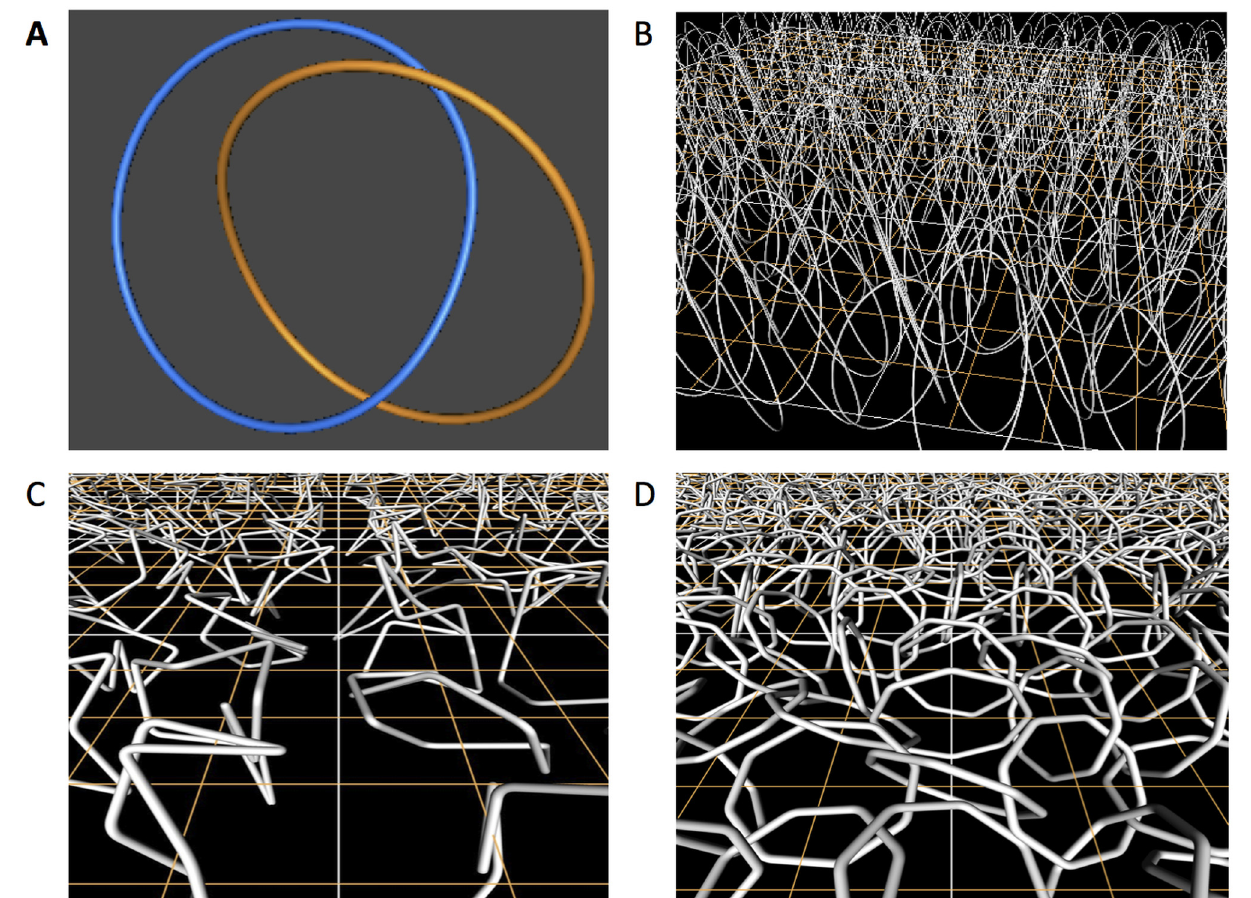
Fig 1. Hopf Links and Models proposed to analyze the topological properties of the minicircle network. A: A Hopf link; B: A grid of minicircles whose orientation has been biased. Volume effects are not considered and minicircle thickness is shown to help trace the trajectory of each minicircle; C: A grid of minicircles represented by freely jointed closed chains to study the effects of DNA bending; D: A grid of minicircles, represented by octagonal polygons, to study the effects of volume exclusion due to electrostatic interactions.